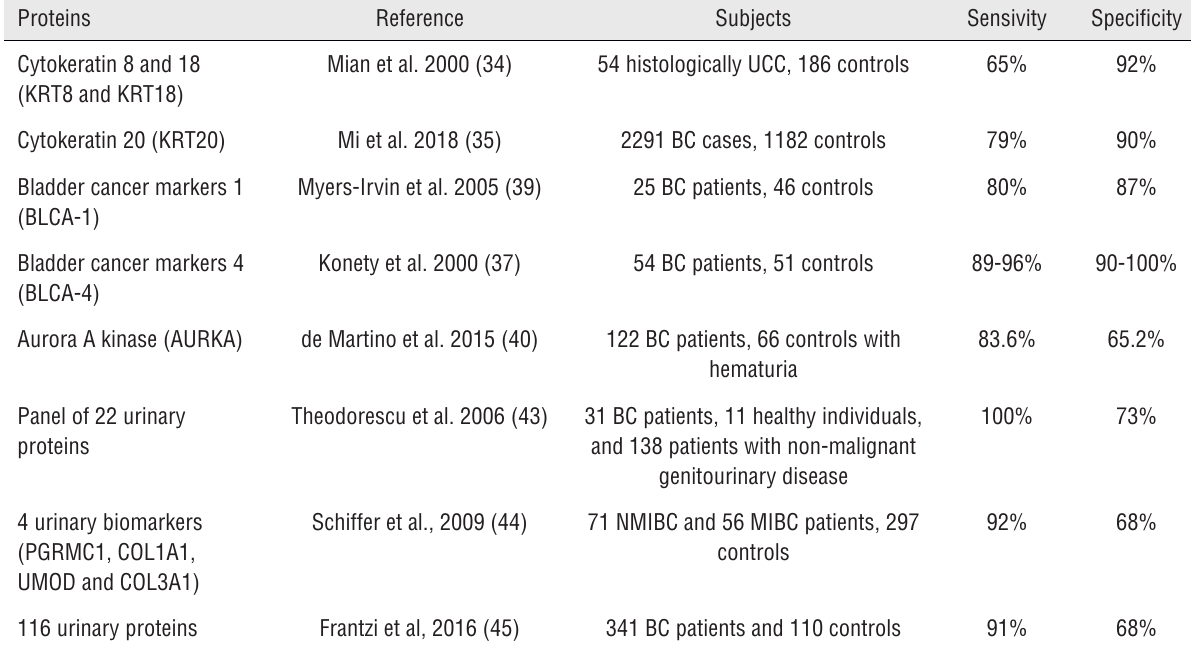
Table 1 - Non-FDA Approved potencial urinary protein biomarkers for bladder cancer detection.